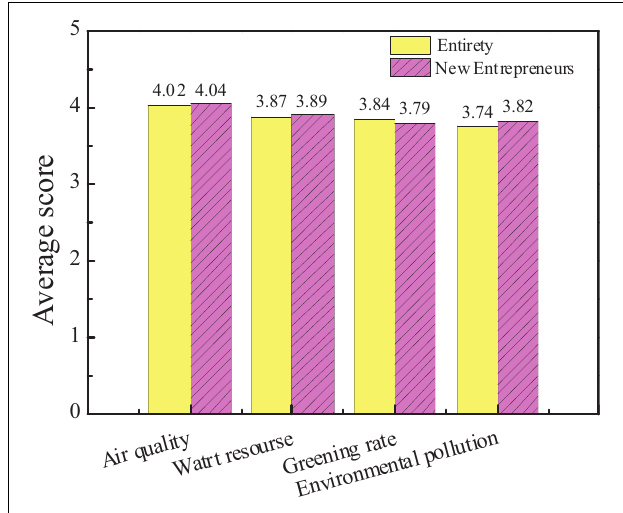
FIGURE 13 | Comparison between the average scores of new entrepreneurs and the overall audience.